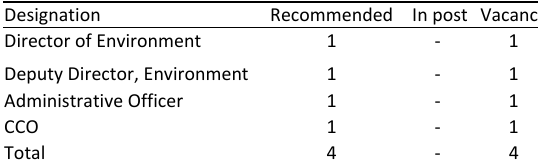
Table 1: Administrative Personnel Involved in SWM (The Director of Environment and Enforcement, 2018) Designation